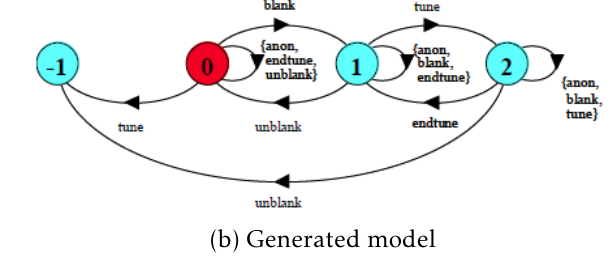
Figure 6. Models of